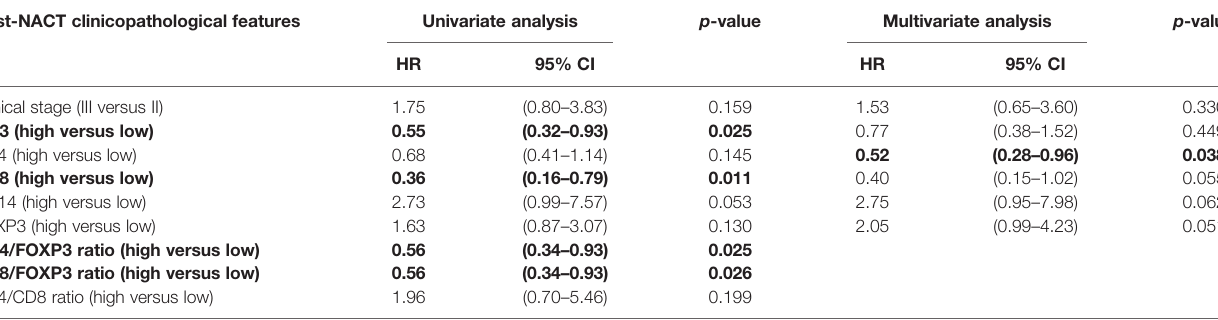
TABLE 3 | Post-NACT clinicopathological features and crude and adjusted hazards ratios for overall survival (OS) estimated by univariate analysis and multivariate analysis.